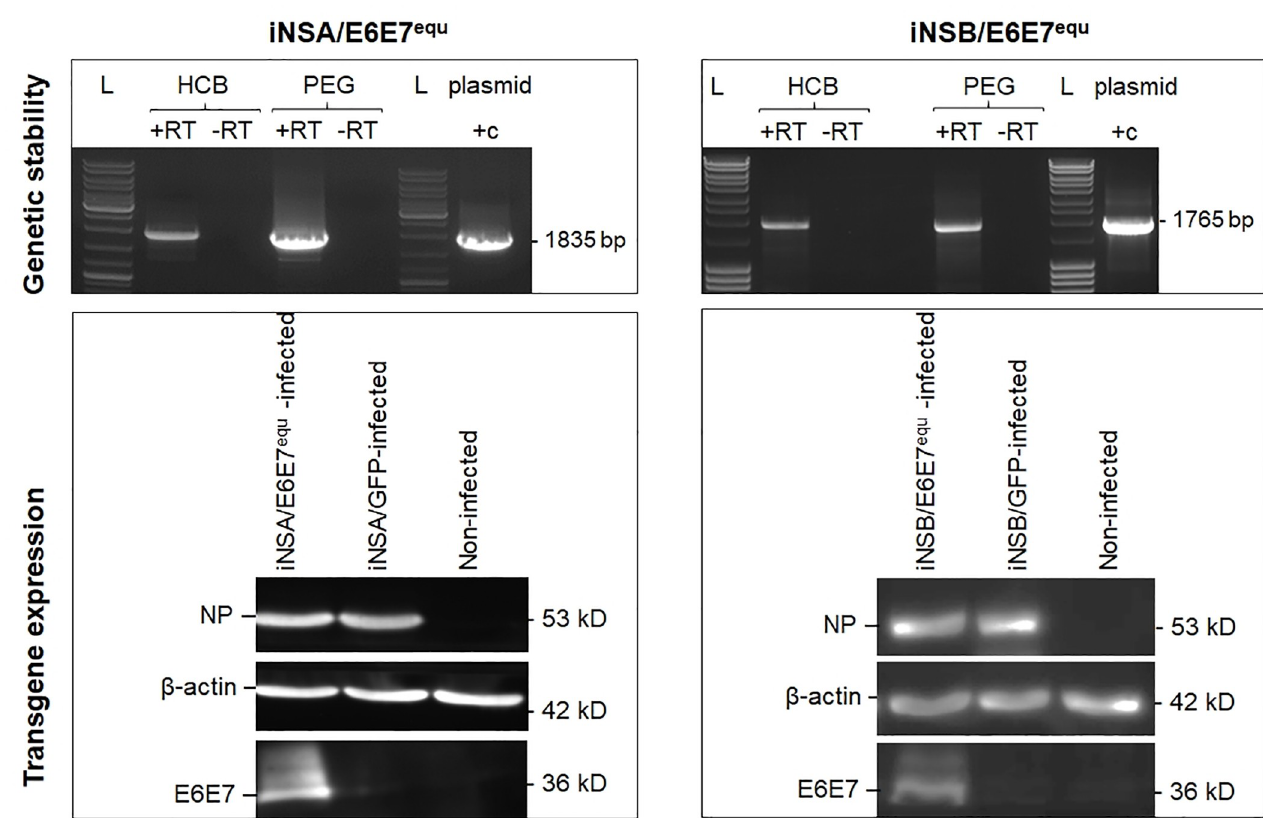
Fig 2. iNSA/E6E7 equ and iNSB/E6E7 equ were genetically stable and expressed shuffled E6/E7 protein. Top: Transgene stability in the iNS1 reading frame was demonstrated by RT-PCR from total RNA after five passages of iNSA/E6E7 equ and iNSB/E6E7 equ in Vero cells. Bottom: Western blot analysis of lysates of equine primary palatal fibroblasts (eqPALF) infected with iNSA/E6E7 equ (left) and iNSB/E6E7 equ (right) revealed stable influenza virus transgene (E6E7) expression.